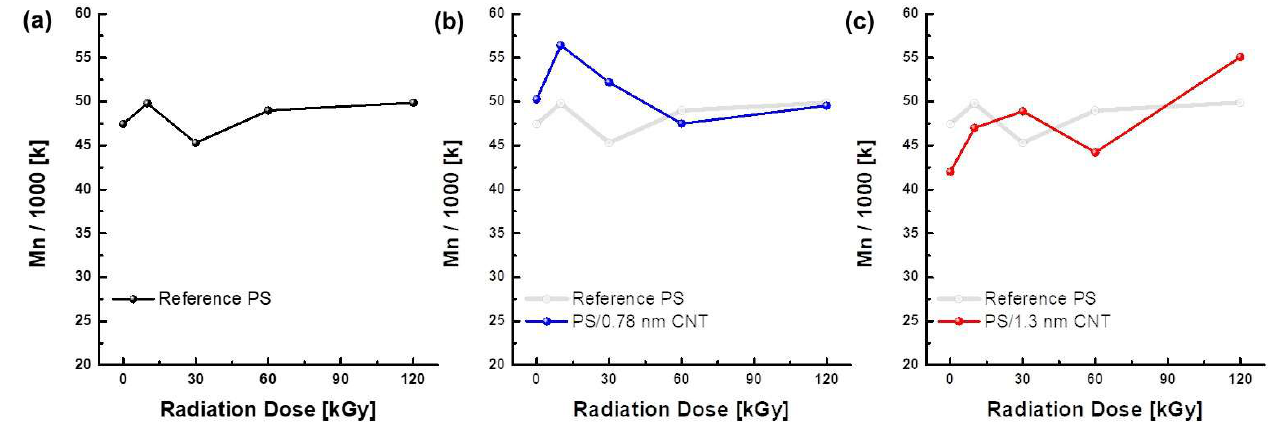
Figure 4. Changes in number-average molecular weight (Mn) of PS ( a ) and PS/SW-CNT composites with diameters of 0.78 nm ( b ) and 1.3 nm ( c ) under gamma irradiation. The FT-IR technique was used to track the changes in the chemical bonding between polystyrene and SW-CNTs (Figure 5). There is no significant change in chemical bonding when a 0.78-nm SW-CNT is introduced, but two peaks centered at 1250 cm − 1 and 1050 cm − 1 appear from 10–60 kGy when 1.3-nm SW-CNTs were introduced. These peaks appear in alkyl aryl ethers, and the oxidation reaction occurs in the case of the 1.3-nm SW-CNTs composites through radiation energy.